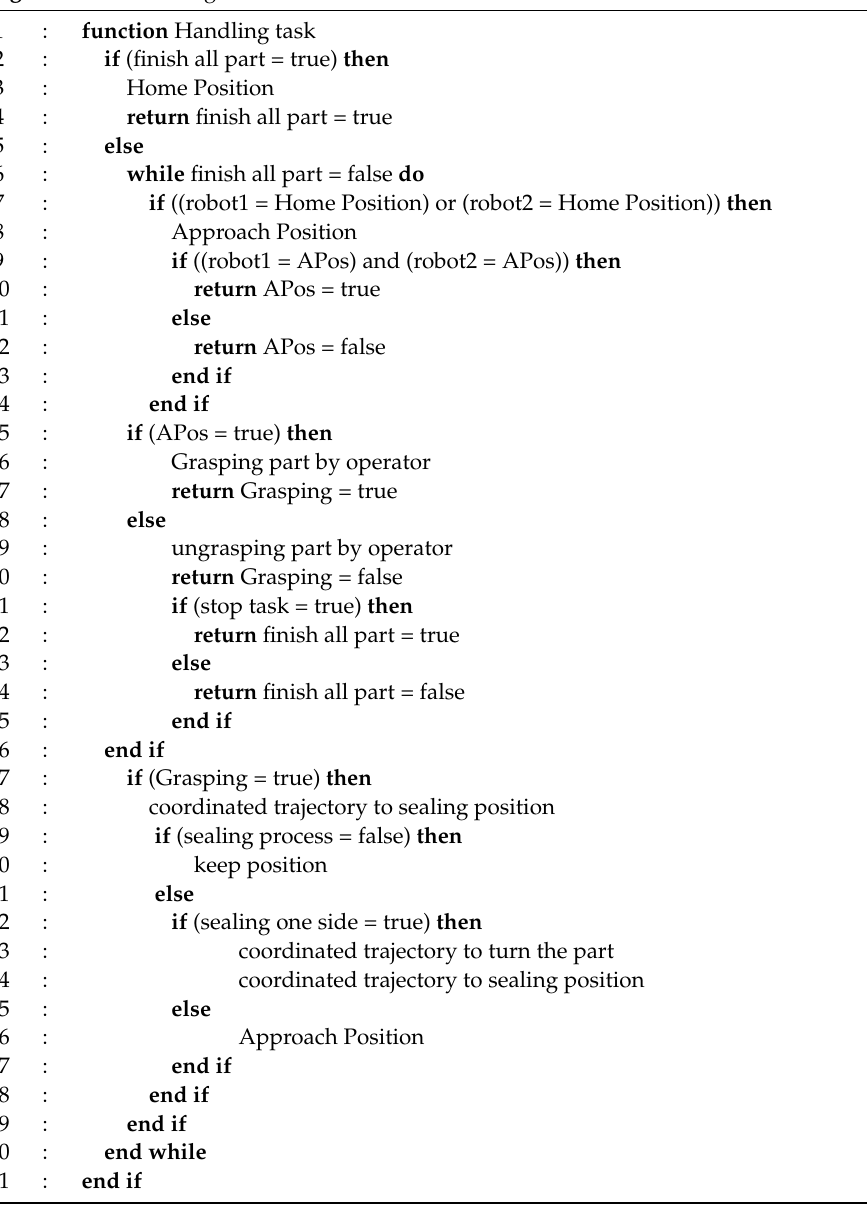
Algorithm 1. Handling